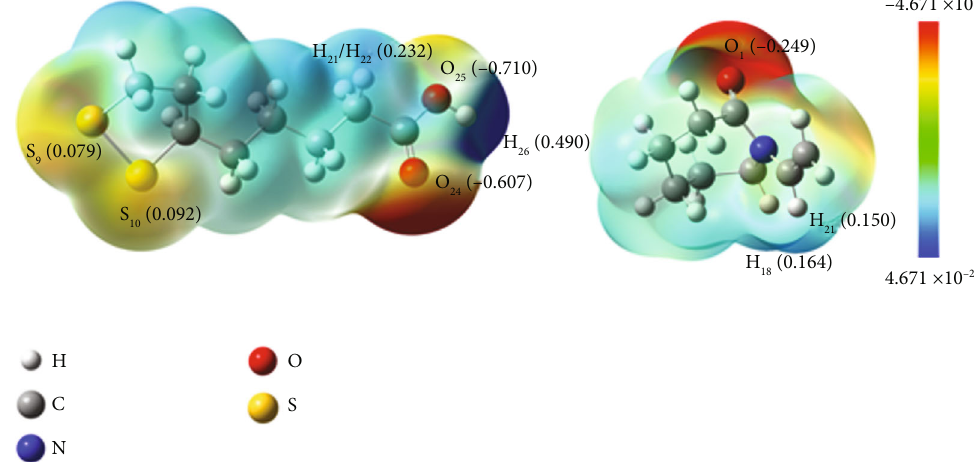
Figure 1: The MEP and NPA population of ALA (a) and NVCL